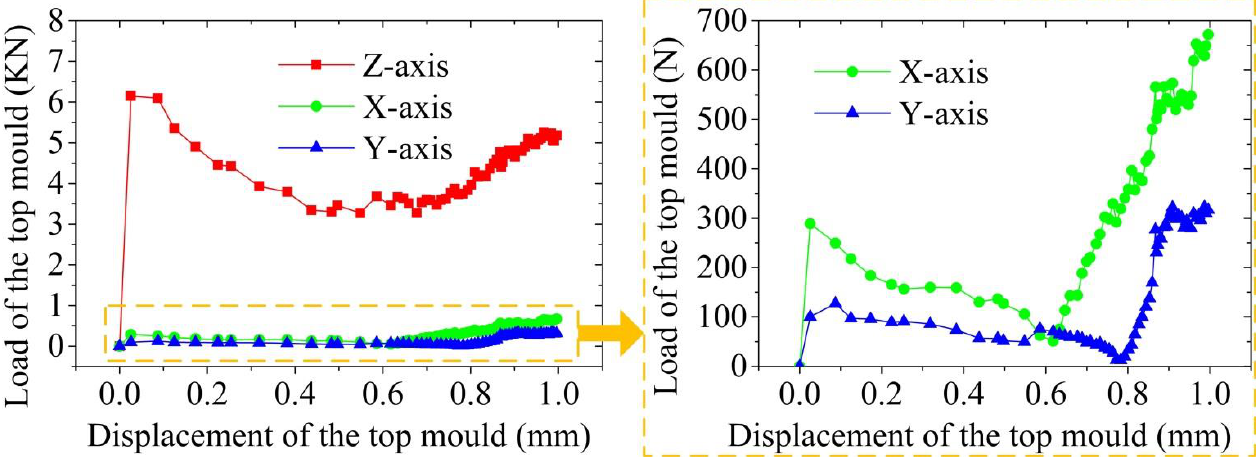
Figure 5. Variation of the load with the displacement of the top mould during the thixotropic extrusion process.